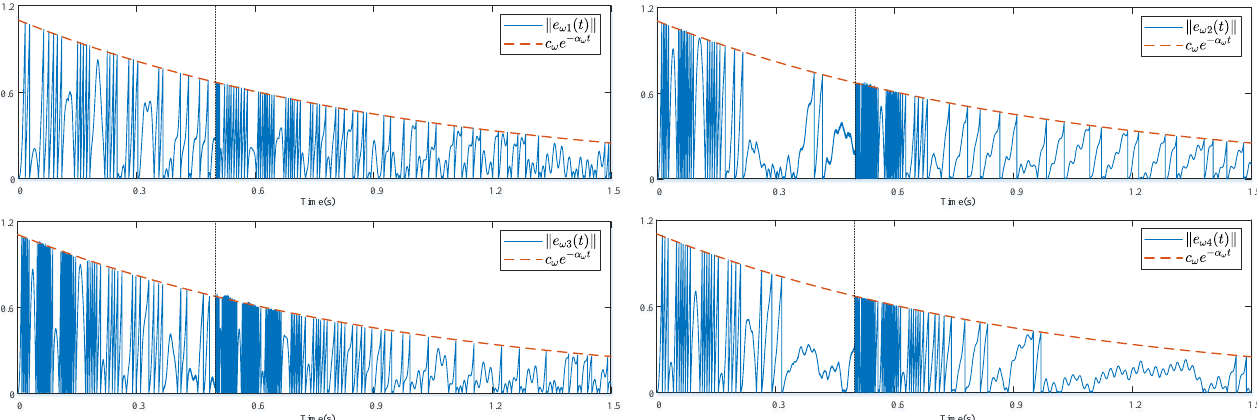
Figure 6. The frequency trigger state diagram for each DG.